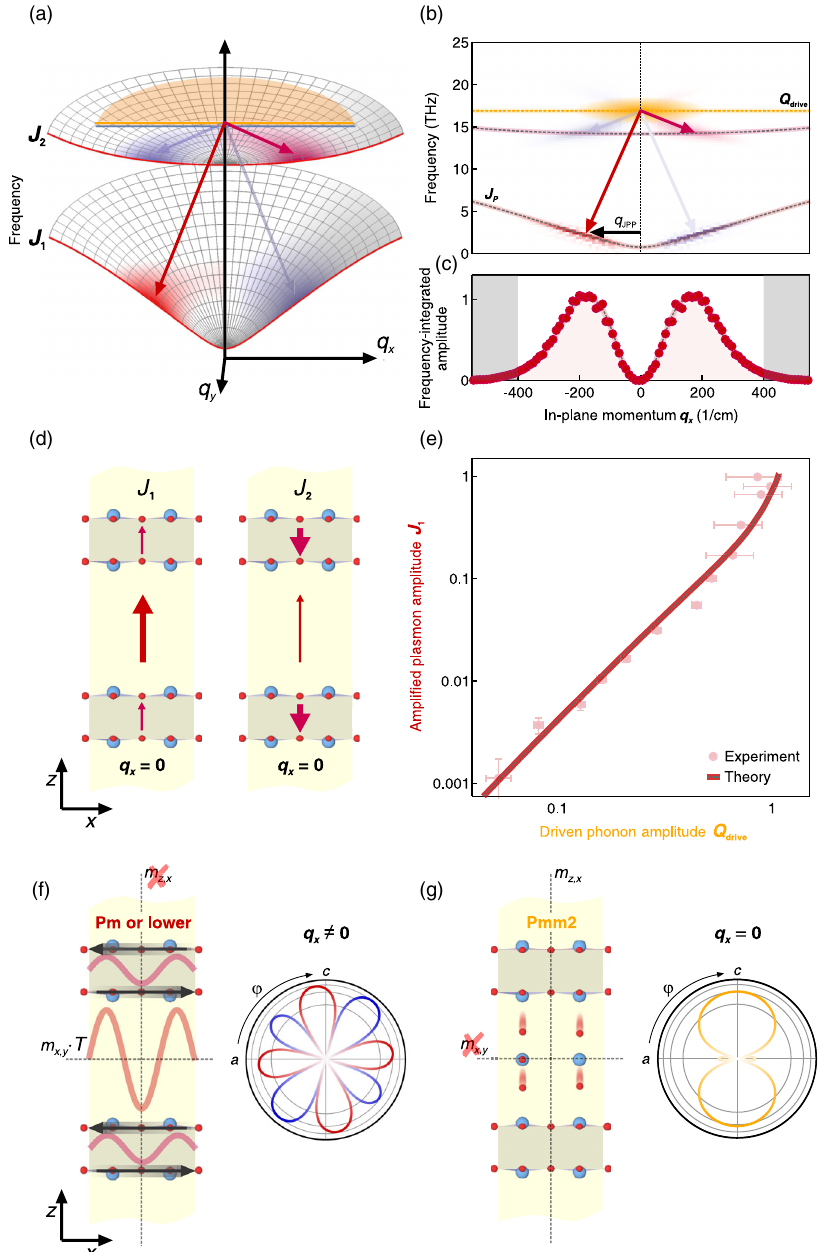
FIG. 5. (a) Dispersion of the interbilayer ( J 1 ) and intrabilayer ( J 2 ) JPP modes along the in-plane momenta q and q in YBa 2 Cu 3 O 6 . x y . 5 0 plane. The apical oxygen phonon mode at 17 THz (yellow) does not disperse along either The red lines are a cut through the q y ¼ direction. The three-wave scattering process is sketched as red and blue arrows and results from a numerical simulation in response to the resonant drive of the apical oxygen phonon at q ¼ 0 are shaded in the same colors. The response vanishes along q , parallel to the y 0 . The driven phonon with zero momentum for q light propagation direction. (b) Detailed insight into the simulation results along q x y ¼ excites a pair of JPPs, J 1 and J 2 , with opposite wave vectors q and frequencies that add up to the phonon frequency. The two JPP processes for mirrored momentum transfer are shown as red and blue arrows, respectively. (c) Amplitude of the JPPs obtained 0 , and peaks at q 200 cm − 1 . (d) Sketch of the integrating along the vertical frequency axis of (b). The amplitude is zero for q x ¼ x ¼ (cid:3) two JPPs at q ¼ 0 , with the supercurrents oscillating in phase ( J 1 ) or out of phase ( J 2 ) for the low- and high-frequency mode, respectively. The thicknesses of the arrows indicate the supercurrent strengths within and between the bilayers. (e) Simulated excitation- strength dependence (dashed line) of the low-frequency 2.5-THz oscillations, together with the experimental data (dots) from Fig. 2(g). (f),(g) Sketch of the real-space symmetries of the finite-momentum amplified JPP ( m or lower) and the driven apical oxygen vibration ( mm 2 ). The in-plane currents (black arrows) and the resulting finite-momentum JPP (red and magenta lines) break the x; z and y; z mirror planes. The optical B 1 -symmetry phonons break the x; y mirror plane u